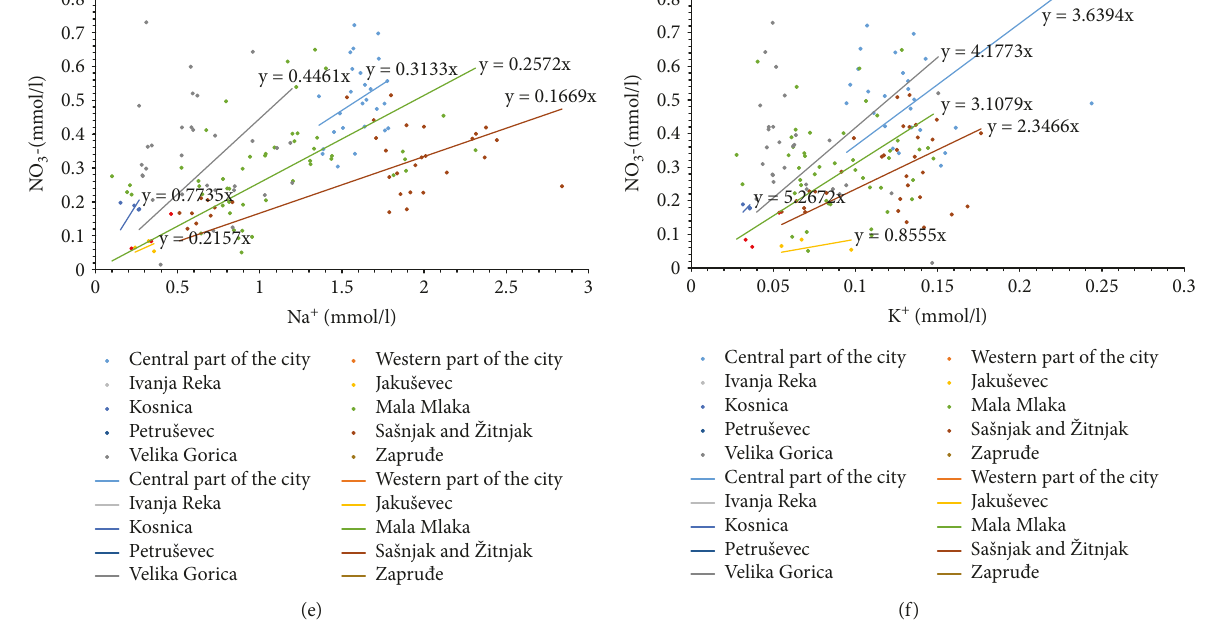
Figure 6: Molar ratios of (a) nitrates and chlorides in the historical data set, (b) nitrates and sodium in the historical data set, (c) nitrates and potassium in the historical data set, (d) nitrates and chlorides in the sampled water, (e) nitrates and sodium in the sampled water, and (f) nitrates and potassium in the sampled